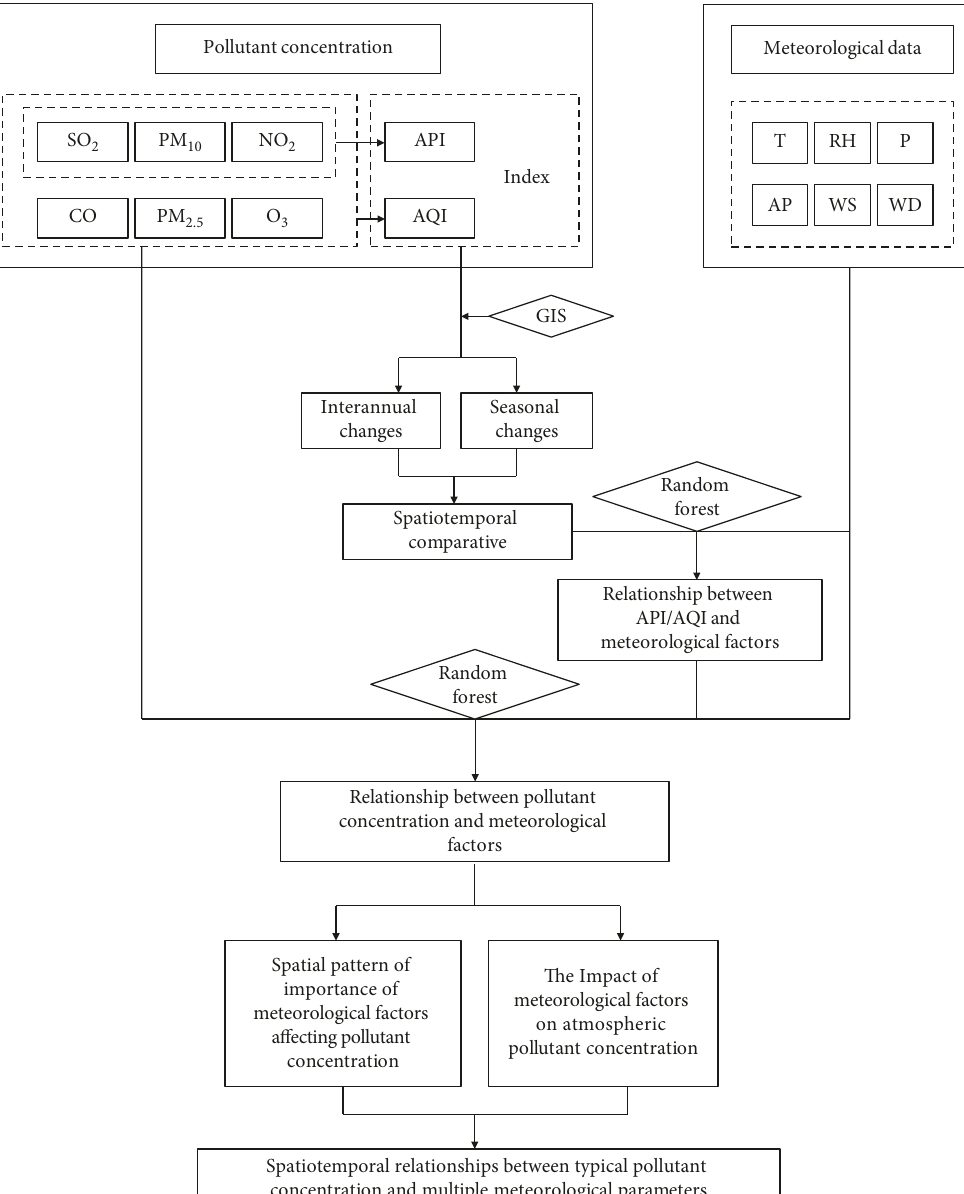
Figure 4: Technology